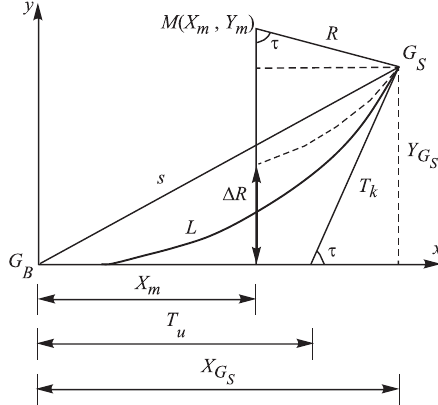
Fig. 3. Elements of general curve: R – radius; X m , Y m – coordi- nate of circle centre; L – transition curve length; G B – transition curve starting; G S – transition curve finishing; X GS , Y GS – carte- sian coordinate of point at junction of the transition curve and circular arc; T k – short tangent; T u – long tangent; ∆ R – curve shift; τ – tangential angle